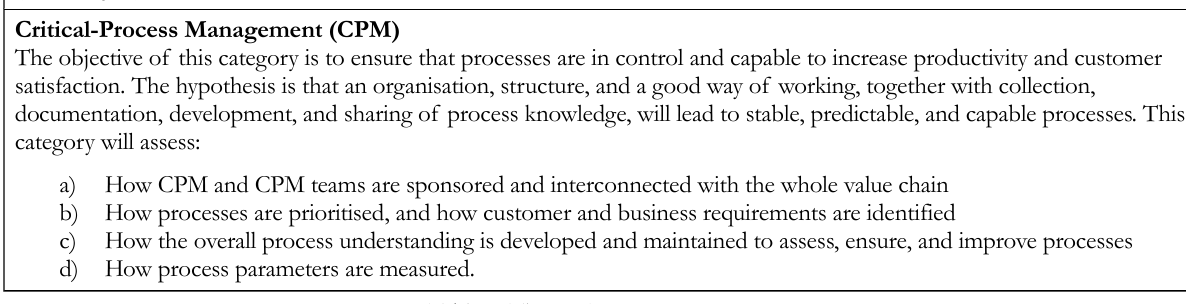
Table 1. The XPS assessment